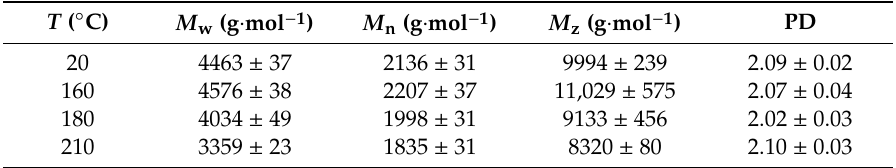
Figure 2. Chromatograms of lignins isolated from untreated and thermally modified iroko wood. Table 5. Results of macromolecular characteristics of lignins from iroko wood. Data represent mean ±